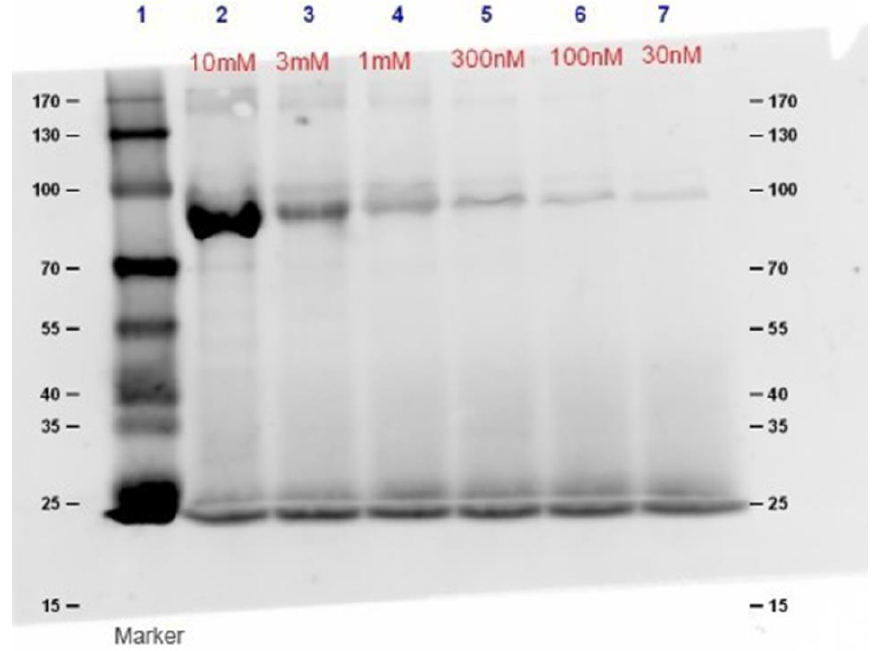
Figure 3. Gel-based fluorescence image after labeling of serum proteomes with various concentrations of probe 1 . Samples were prepared by incubating 2.0 mg/mL proteomes at different conditions: Lane 1 — Marker; Lanes 2 – 7 with 10, 3, and 1 mM, and 300, 10 and 30 nM probe 1, and exposed to UV light for 30